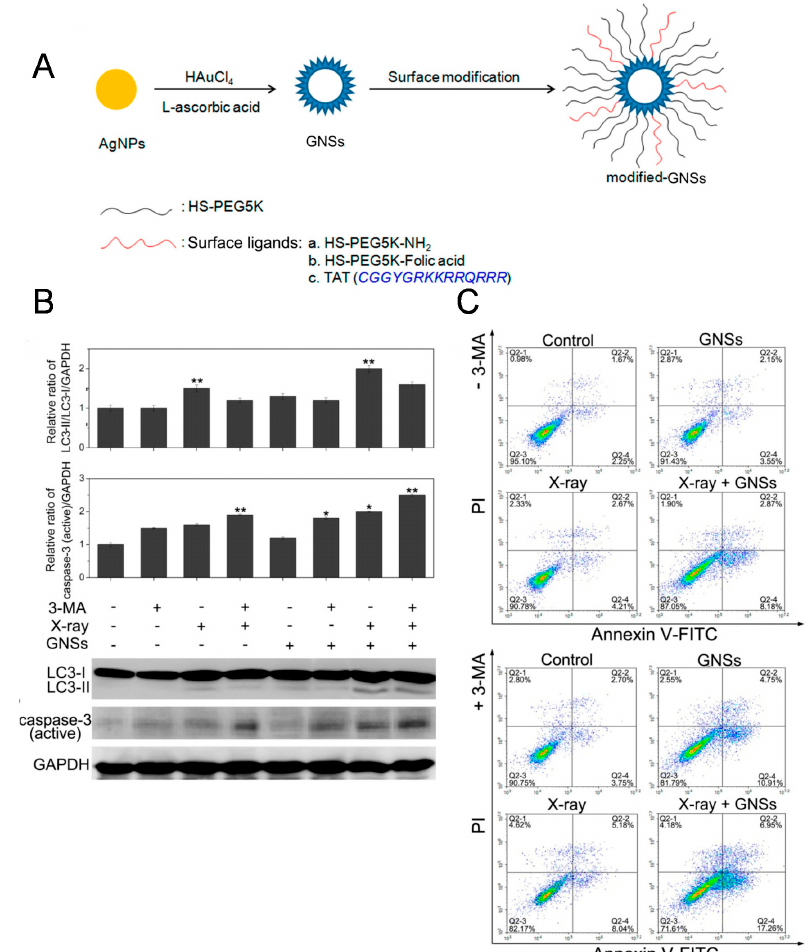
Figure 3. Enhancing RT for therapeutic resistance by combination with autophagy inhibitor 3-MA. ( A ) Schematic illustrating the preparation of PEG-modified GNSs. ( B ) Effect of 3-MA, X-ray, and GNSs on the expression level of LC3-I, LC3-II, and caspase-3 (active) in KB cells. The relative ratio of LC3-II/LC-I and caspase-3 (active) were quantified by integrated optical densitometry (IOD). n = 3; * p < 0.05; ** p < 0.01. GAPDH served as a loading control. ( C ) Effect of 3-MA on